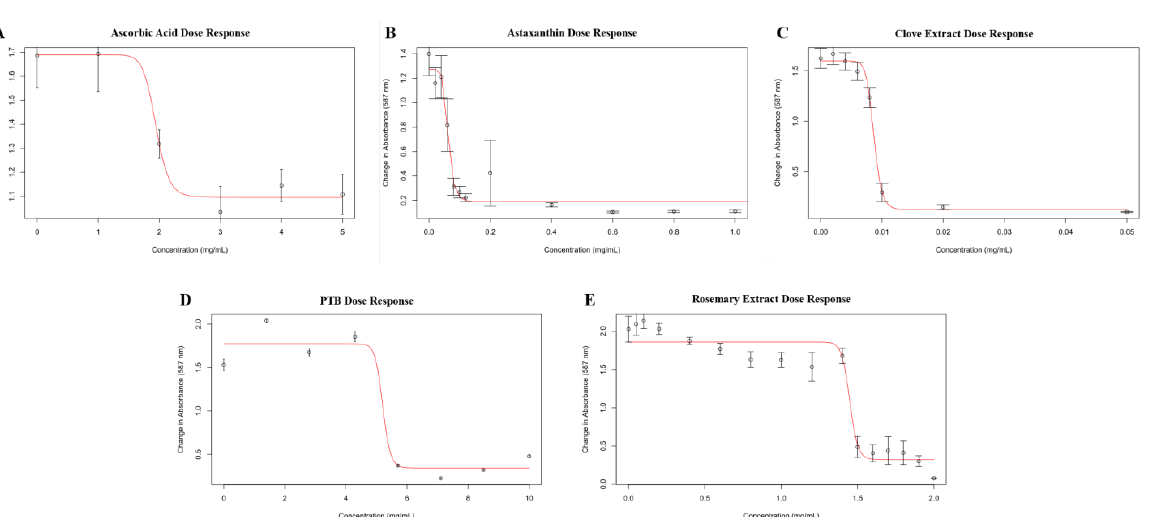
Figure A2. Cell Viability. S. aureus cell viability after 24 h of incubation under planktonic conditions with additives. ( A ) Ascorbic acid, ( B ) Astaxanthin, ( C ) Clove extract, ( D ) PTB, ( E ) Rosemary extract.